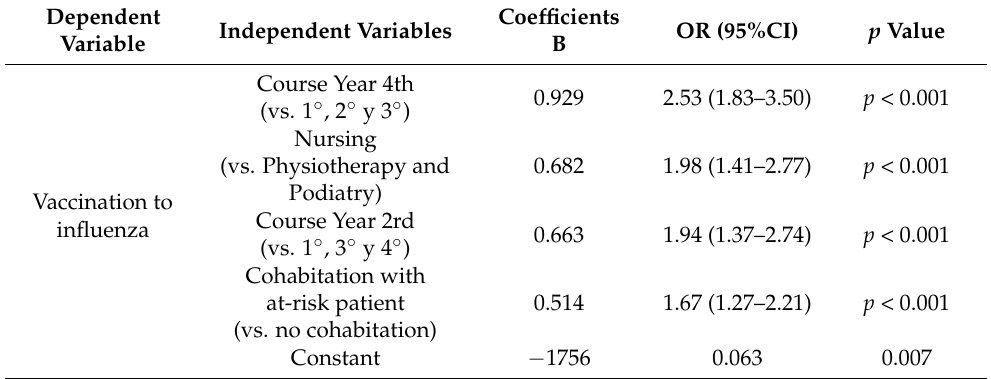
Table 4. Multivariate model using logistic regression: variables influencing influenza vaccination